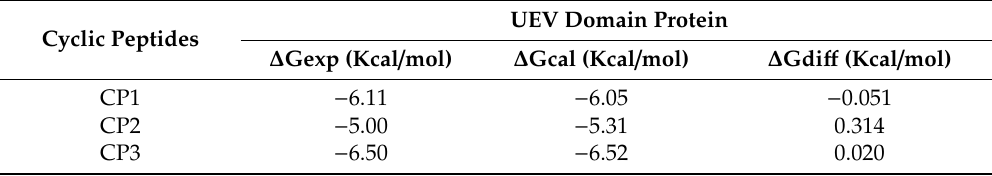
Table 4. Free energy prediction results of cyclic peptides for inhibiting UEV domain protein. UEV Domain Protein Cyclic Peptides ∆ Gexp (Kcal / mol) ∆ Gcal (Kcal / mol) ∆ Gdi ff (Kcal / mol) CP1 − 6.11 − 6.05 − 0.051 CP2 − 5.00 − 5.31 0.314 CP3 − 6.50 − 6.52